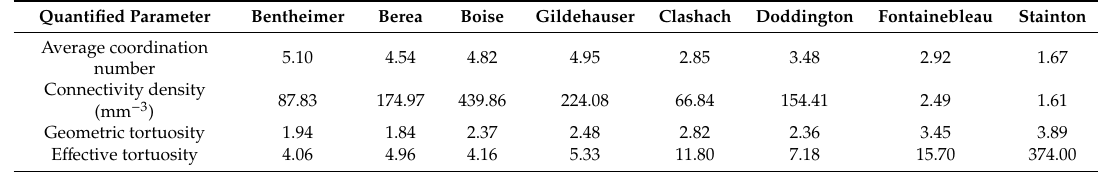
Table 2. Quantified topological parameter.